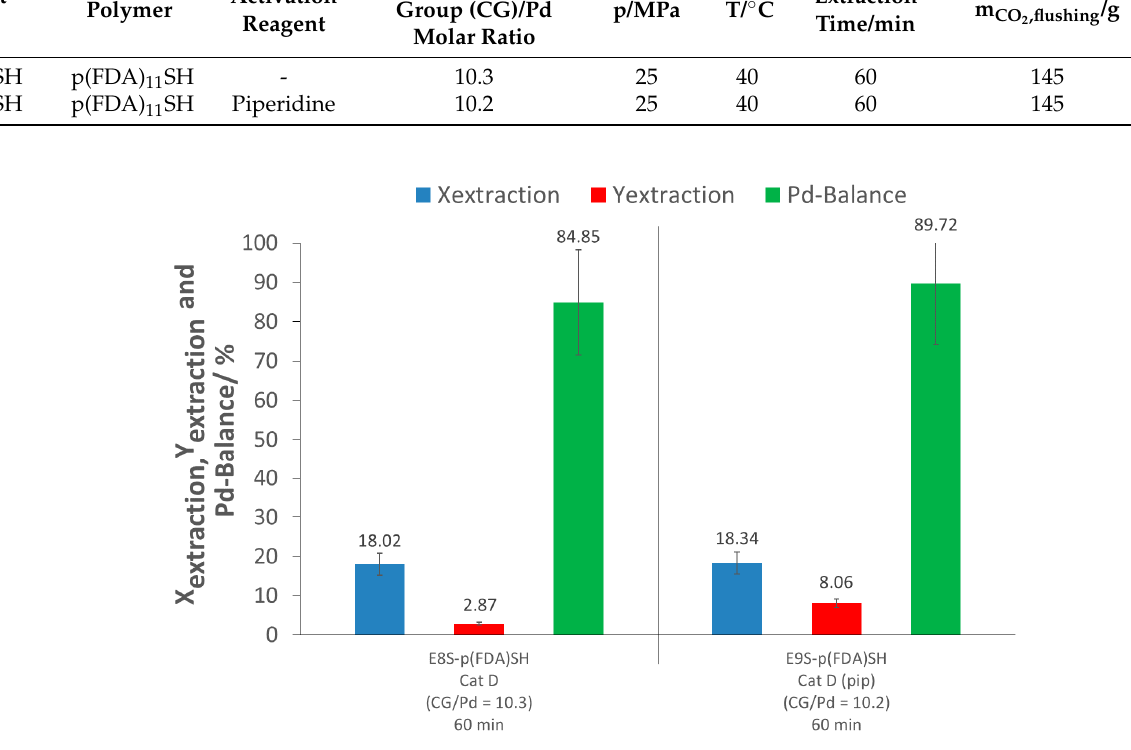
Table 3. Extraction parameters for extractions performed with polymer p(FDA)SH (ExS-p(FDA)SH: Screening experiments). Experiment